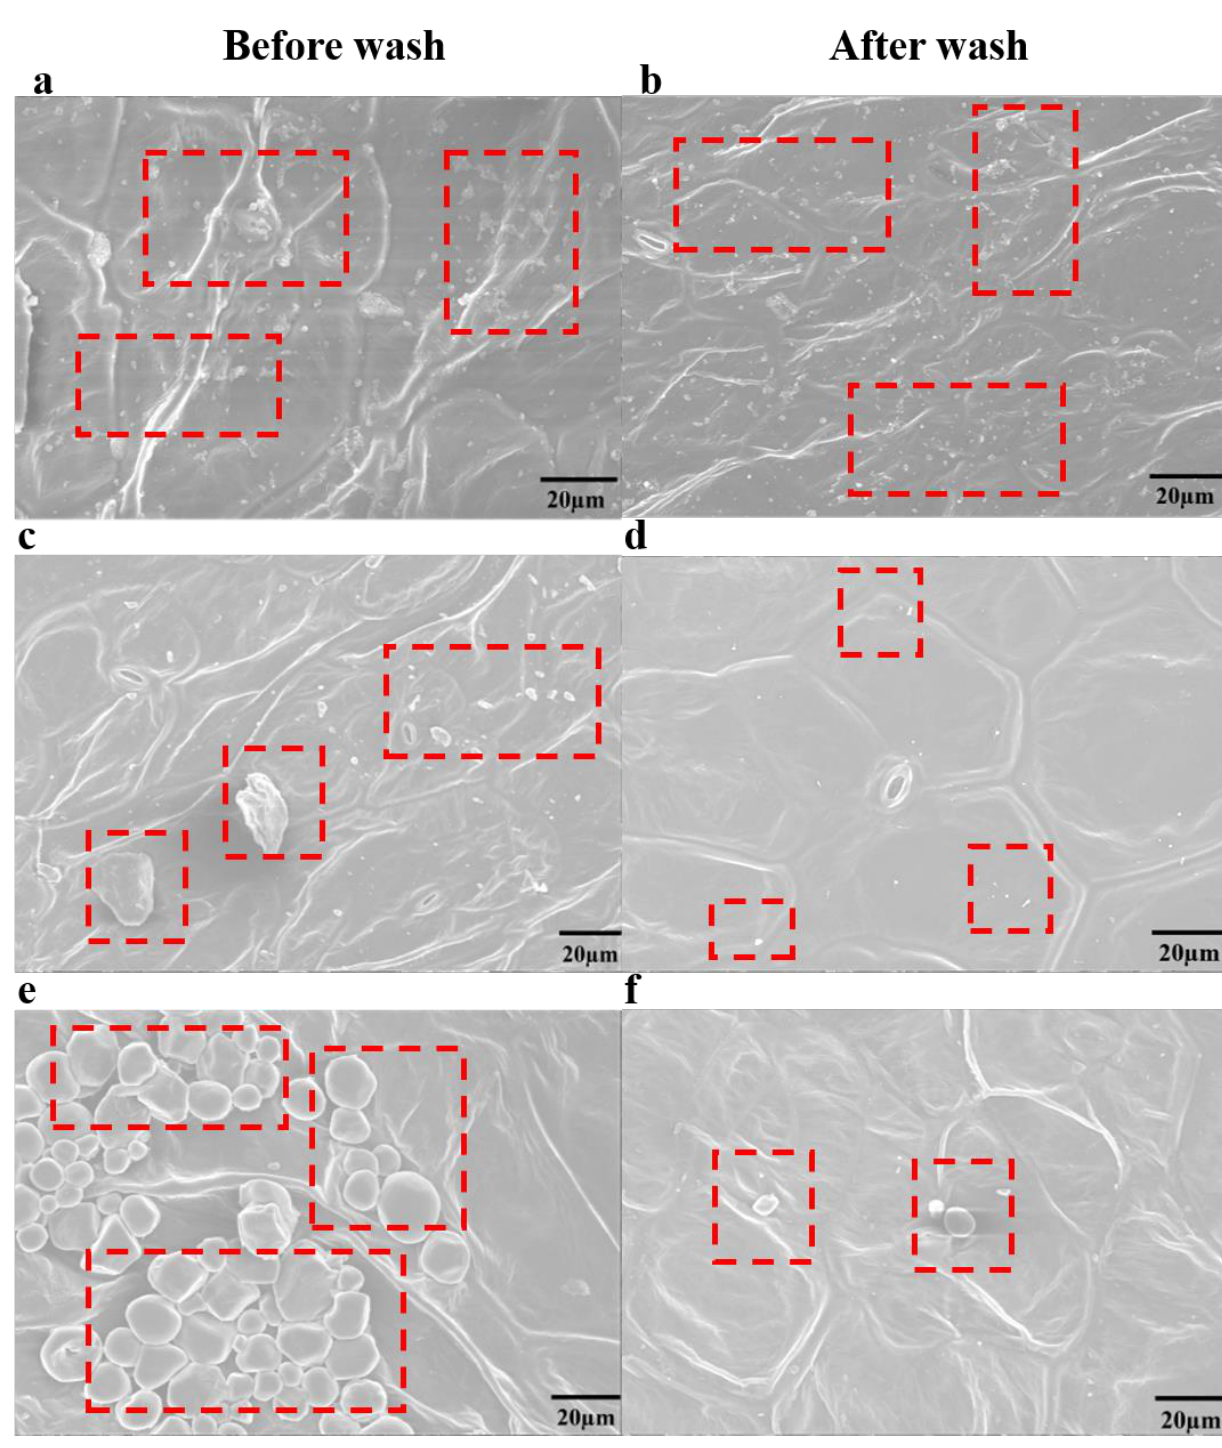
Figure 10. SEM images on cabbage leaves. ( a ) Image with nano-microcapsules, ( c ) image with WDG-Chl, ( e ) image with WDG-LC. ( b , d , f ) are the corresponding images after washing. The scale bar is 20 µm.